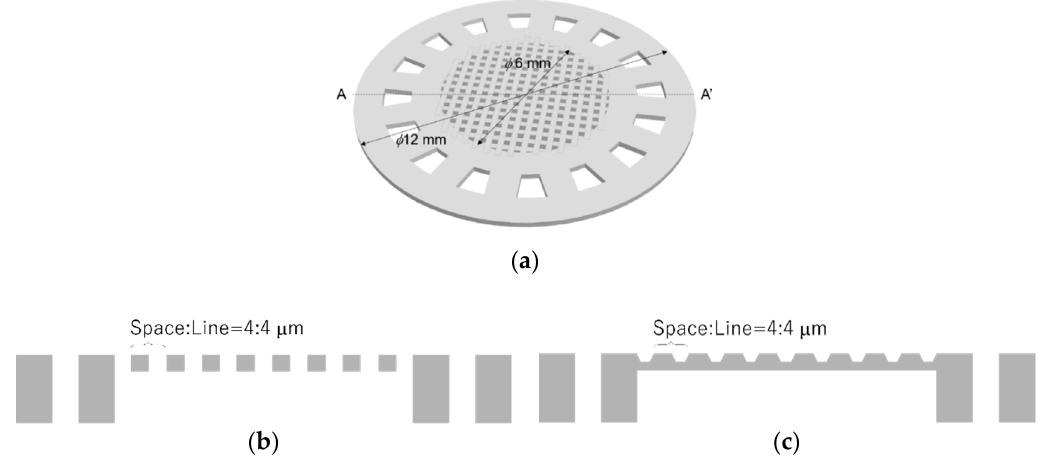
Figure 1. Schematic images of the cell culture plate. The cell culture plate had the 3D lattice structure with a diameter of φ 6 mm. ( a ) 3D lattice structure was supported by the ring structure. The diameter included ring structure was φ 12 mm. The 3D lattice structure fabricated by the mask pattern having 4:4 µm space and line patterns. We designed two types of 3D lattice structures which were ( b ) porous structure and ( c ) the rough surface having no pores. These structures were fabricated by using the same mask pattern and adjusting exposure energy.